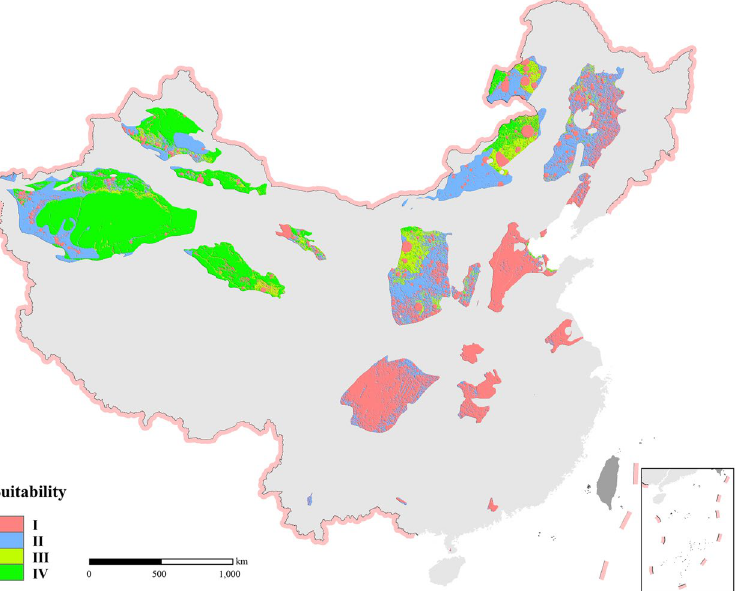
and IV with increasing suitability. The map in this figure were generated by software ArcGIS 9.2 (http:// www.esri.com/arcgis/about-arcgis) based on our own data. The China spatial boundary GIS data is from the National Geomatics Center of China (affiliated with National Administration of Surveying, Mapping and Geoinformation of China), which provides the basic GIS data for